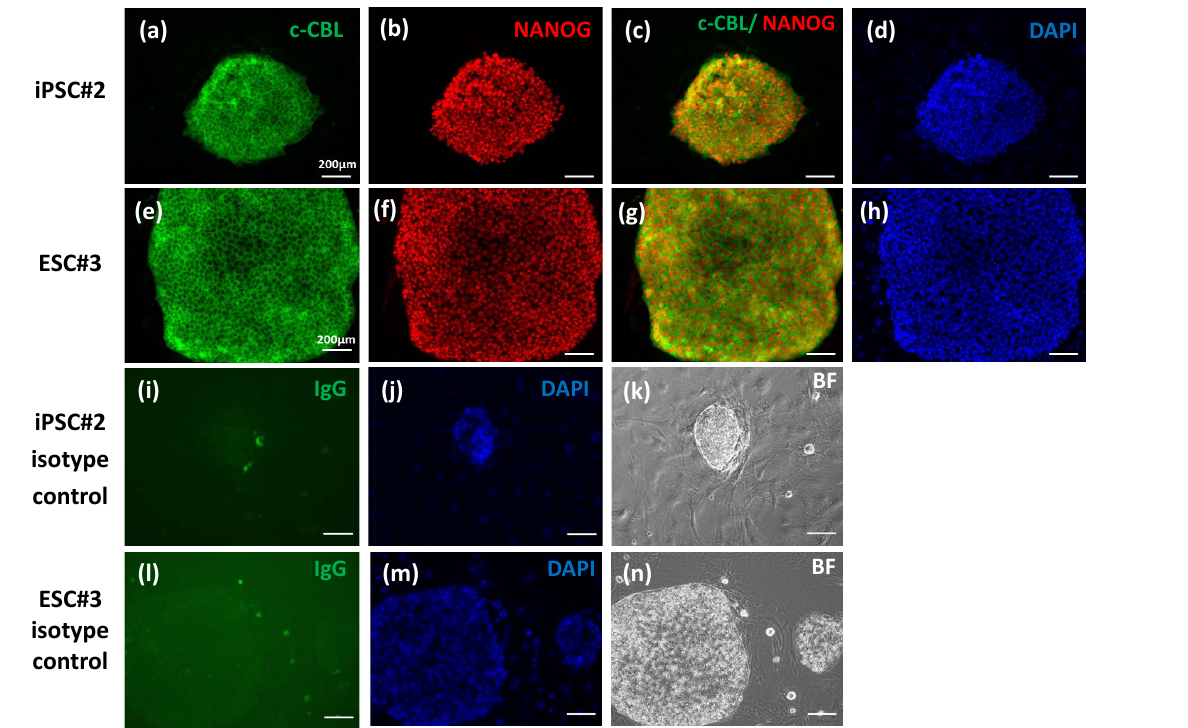
Figure 3. Immunofluorescence analysis of c-CBL expression in comparison with NANOG expression in cultured marmoset iPS and ES cells. The stem cells were cultured on mouse embryonic feeder (MEF) cells. The upper panels (a–d) show the iPS cell line 2, while (e) – (h) show the ES cell line 3. (i) – (k) and (l) – (n) show the respective IgG controls and the bright field (BF) images of the control